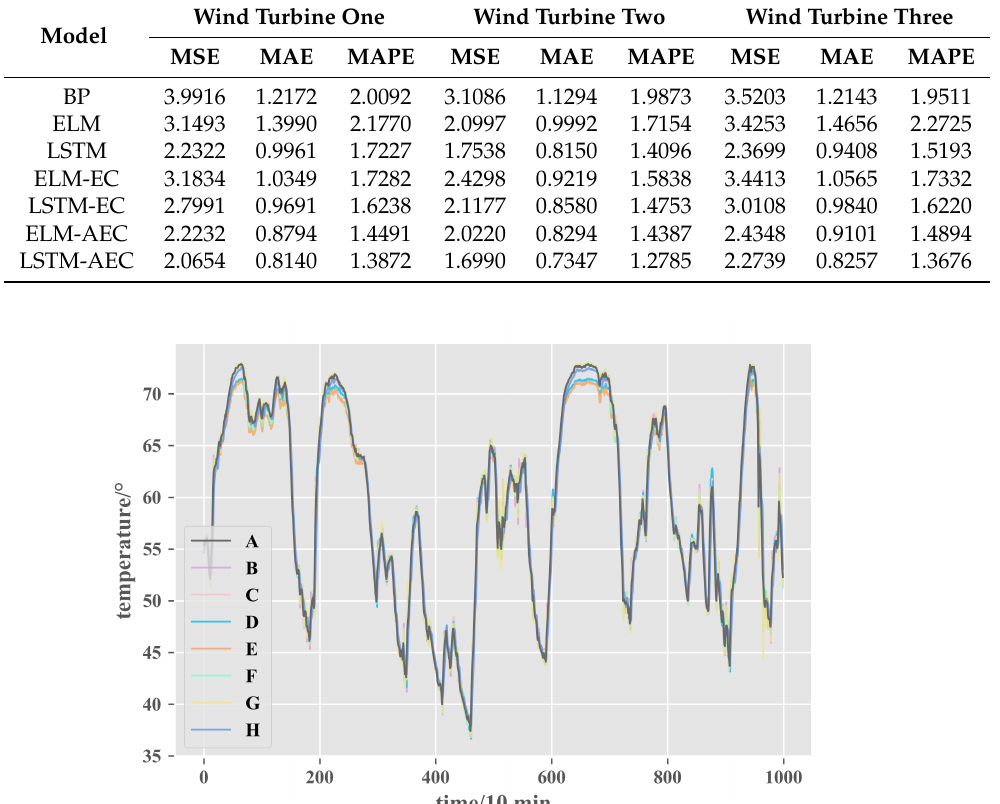
Figure 6. The comparison of different models for gearbox oil temperature prediction in